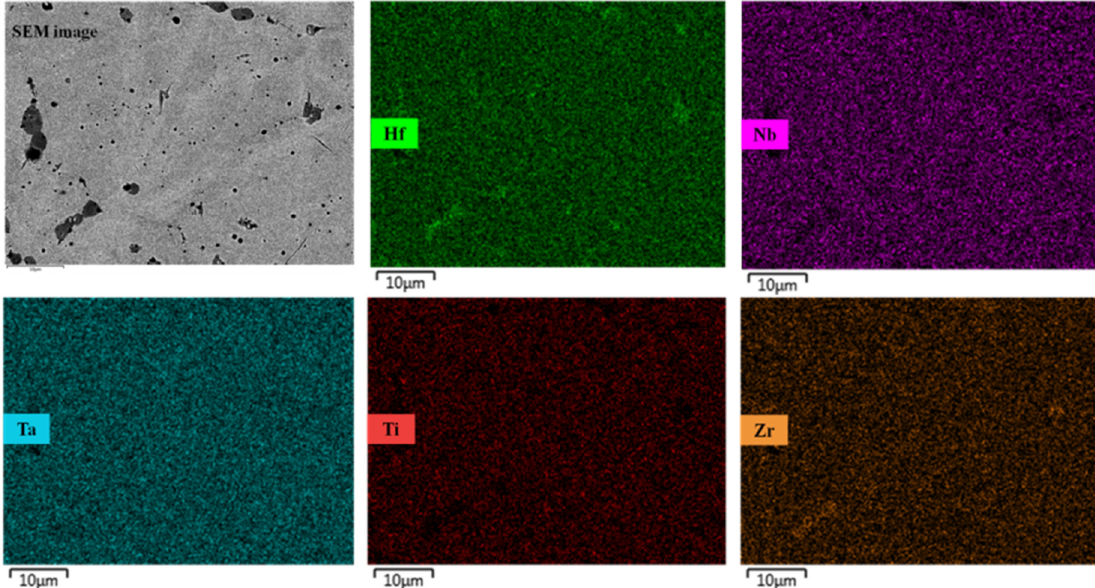
Figure 9. Representative compositional EDX mapping results for the HfTaTiNbZr sample consolidated at 1300 °C for 10 min after 10 h of LEBM.